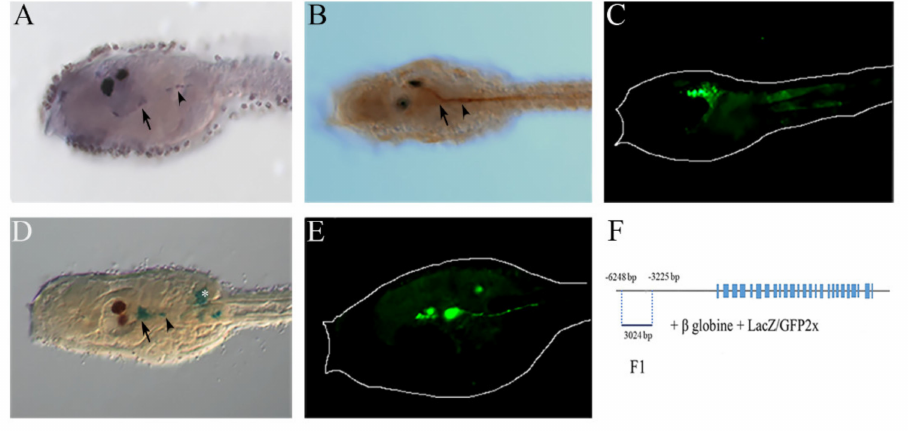
Figure 2. NOS and NO localization in Ciona larvae in anterior CNS. ( A ) Nos gene expression in posterior sensory vesicle (arrow) and neurons of the motor ganglion (arrowhead) at the early to mid-larval stage. ( B ) Immunochemistry assay of NOS, using antibody uNOS, at the mid-larval stage, showing enzyme expression in the posterior sensory vesicle (arrow) and motor ganglion neurons (arrowhead). ( C ) NO localization using DAF-FM-DA at the mid-larval stage. ( D , E ) LacZ and GFP staining of Ciona F1 Nos regulatory activity in the same regions of the CNS labeled by NOS transcript and enzyme (corresponding arrows and arrowheads). ( F ) Schematic representation of F1 construct and position of F1 regulatory region along the Nos gene